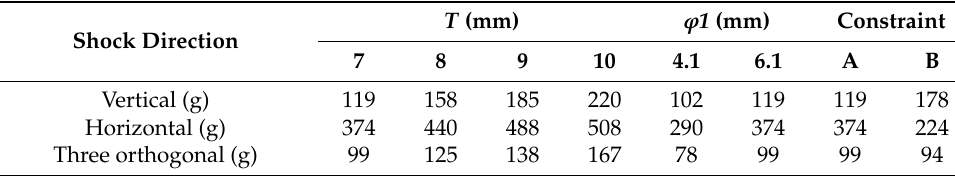
Table 2. Maximum shock acceleration that the ultra-stable optical cavity can